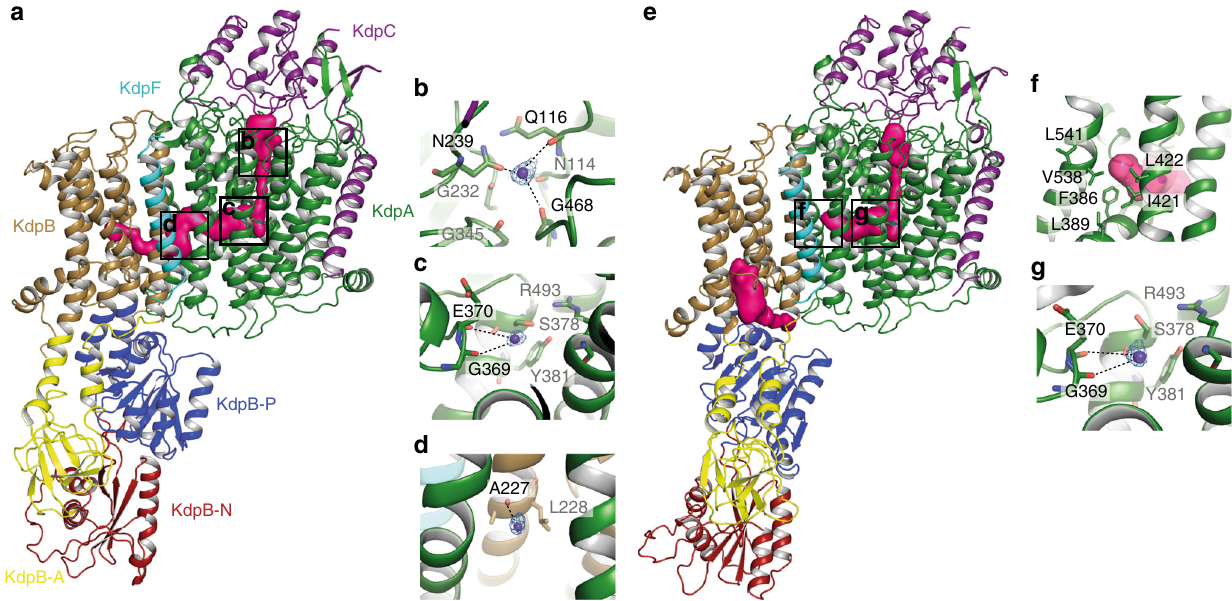
Fig. 3 Outward-open and inward-open half-channels in states 1 and 2 of KdpFABC. a Entrance tunnel in state 1 covering the selectivity fi lter and the inter- subunit tunnel between KdpA and KdpB. b – d Magni fi cation of the K + binding sites inside the entrance tunnel in state 1 shown with corresponding cryo-EM density map for the potassium ions sharpened with b-factors of − 205 Å 2 at 5.5 σ ( b ), 6.0 σ ( c ), and 6.5 σ ( d ). Coordinating residues are represented as sticks. e Blocked entrance tunnel at the KdpA-KdpB interface and open exit pathway between KdpA and the P domain of KdpB in state 2. f Close-up view of the entrance tunnel blockage in state 2. Tunnel-blocking residues of KdpA are represented as sticks. g Magni fi cation of the K + binding site inside the residual entrance tunnel in state 2 shown with cryo-EM density map for K + sharpened with a b-factor of -195 Å 2 at 5.5 σ . Coordinating residues represented as sticks. Potassium ions are shown as dark purple spheres. Entrance and exit tunnel surface representations (pink densities) were calculated with Hollow